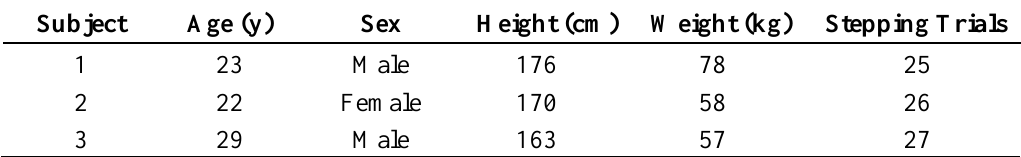
Table 1. Age, sex, height and weight, and the numbers of stepping trials for stepping exercise for each